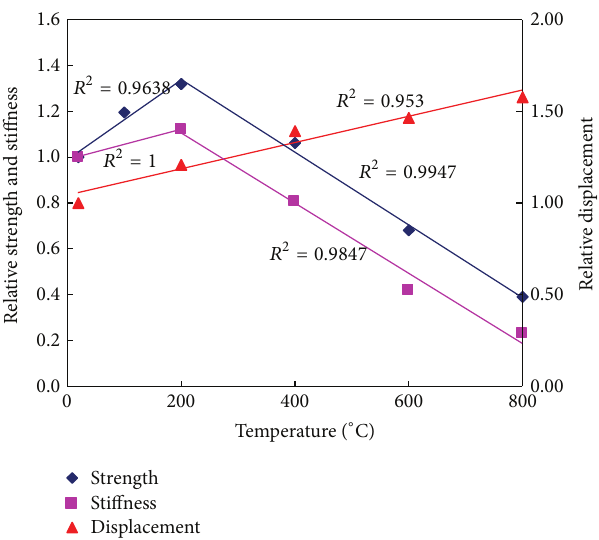
Figure 6: Compressive strength, stiffness, and displacement corre- sponding to the peak load with temperatures.